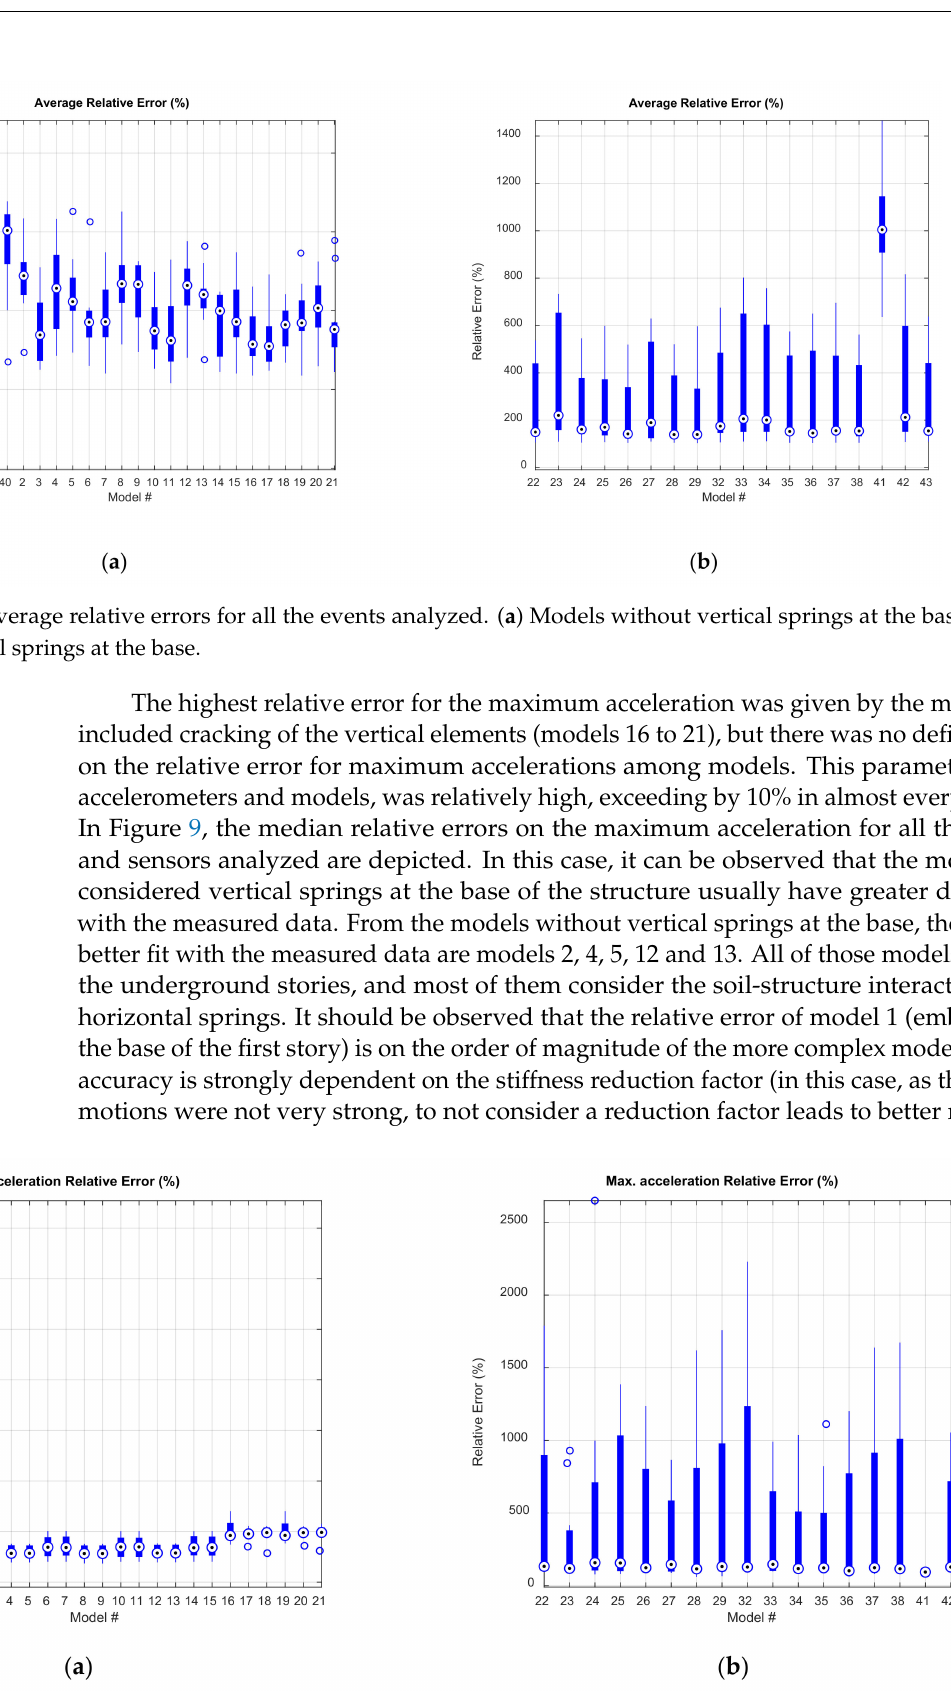
Figure 9. Median relative errors on the maximum acceleration of the records. ( a ) Models without vertical springs at the base; ( b ) models with vertical springs at the